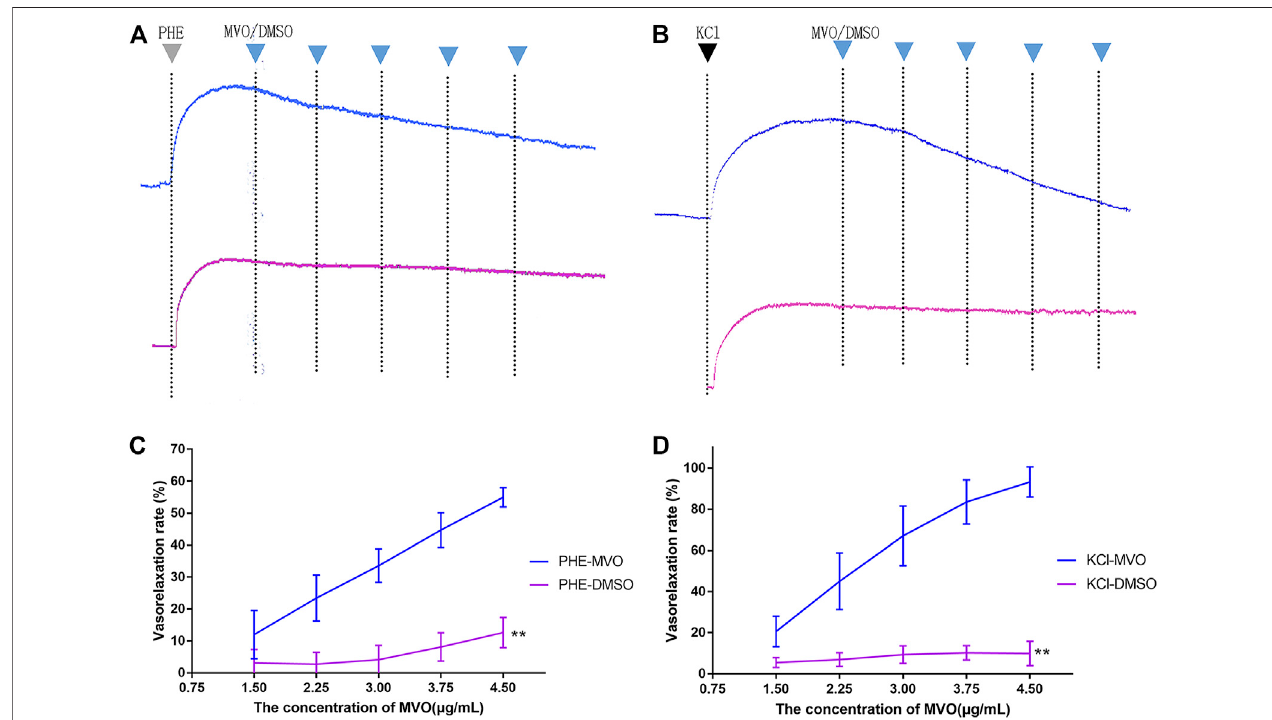
FIGURE 4 | Effect of cumulative doses of MVO (the blue line) and DMSO (the purple line) on the relaxation of rat aortas precontracted by (A) 10 μ M PHE and (B) 60 mM KCl. (C) Relaxant effects of MVO (1.5, 2.25, 3, 3.75, and 4.5 μ g/ml) on contractions induced by PHE (10 μ M). The alternation of tension was expressed as the percentage oftheactive contractionsinducedby PHE (10 μ M). (D) Relaxant effects ofMVO(1.5, 2.25, 3,3.75, and 4.5 μ g/ml)on contractionsinduced byKCl (60 mM). The alternation of tension was expressed as a percentage of the active contractions induced by KCl (60 mM). n = 6. Means ± S.D. * p < 0.05, ** p < 0.01 vs. KCl/ PHE-MVO group.